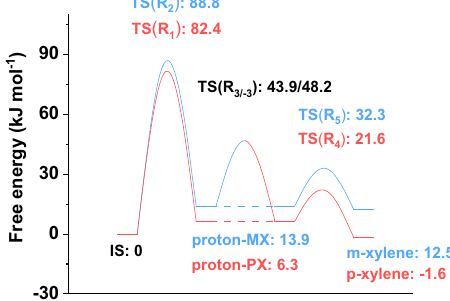
Fig. 6 Free energy pro fi le of the reactions between toluene and methanol. The reactions considered include the formation of p-xylene and m-xylene, and the mutual isomerization of p-xylene and m-xylene. The states linked by dashed lines indicate the same intermediates in the